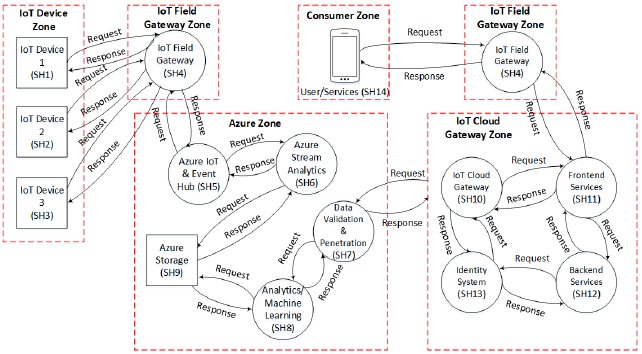
Figure 6. Data Flow Diagram (DFD) of Smart Home